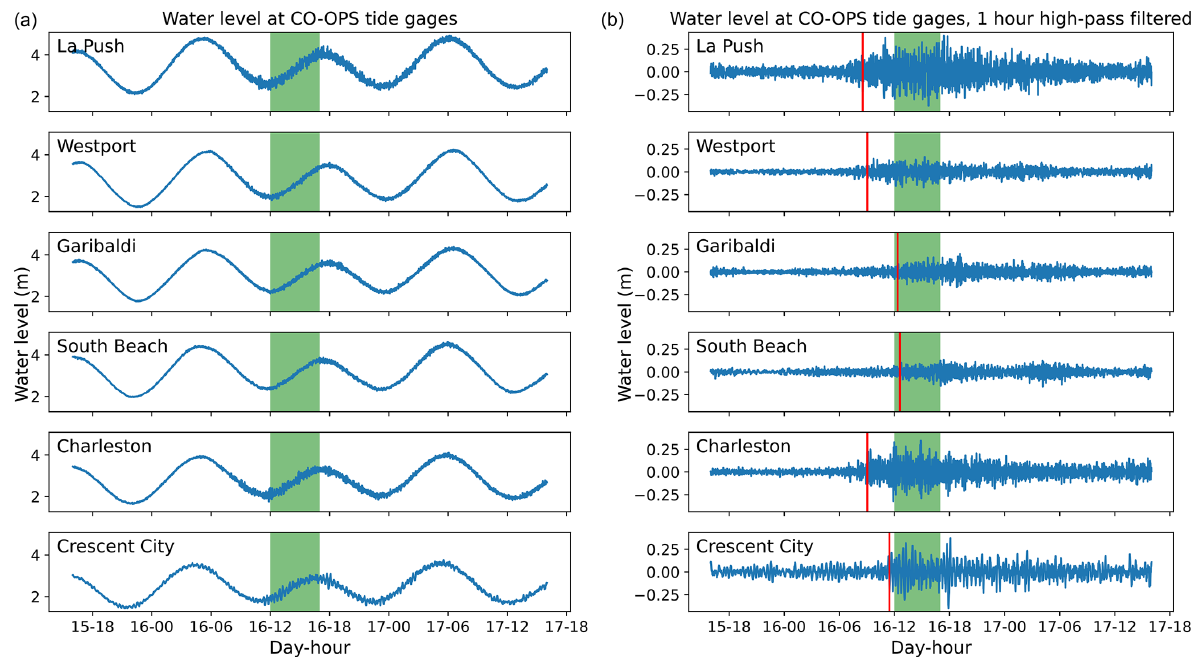
Figure 5. Water level at NOAA CO-OPS tide gages from 16–18 January 2016 ( a , ordered north to south from top to bottom, time in PST, i.e., local). The green bar indicates the duration of observed large runup events. (b) The 1h high-passed version of (a) . The vertical red line represents the approximate onset of the anomalous water level fluctuations, defined as having 1h high-passed fluctuations greater than 2.5 times their standard